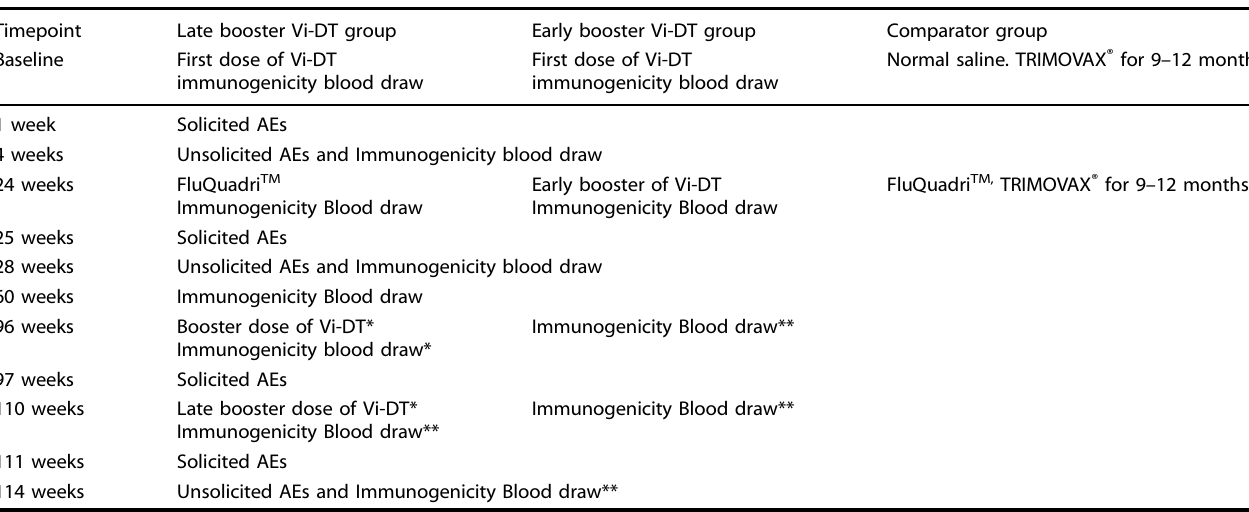
Table 3. Vaccination schedule and outcome assessment in the two Vi-DT groups and the